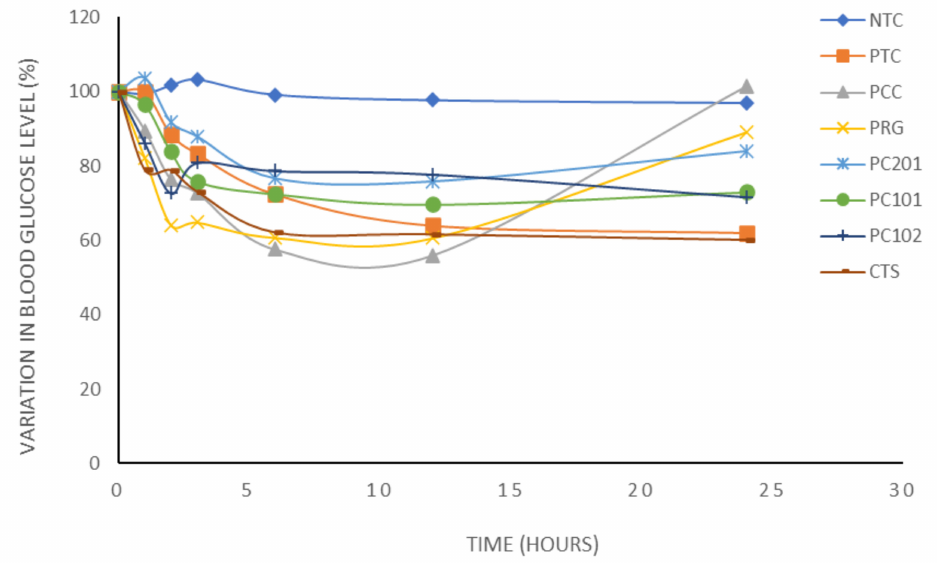
Figure 3. Antidiabetic effect over a 24-h period after single-dose administration of the various formulations (NTC = negative control, PTC = positive control, PCC = unloaded nanoparticles, PRG = prosopis gum-based insulin nanoparticles, PC201 = Prosochit ® 201-based insulin nanopar- ticles, PC101 = Prosochit ® 101-based insulin nanoparticles, PC102 = Prosochit ® 102-based insulin nanoparticles, CTS = chitosan-based insulin